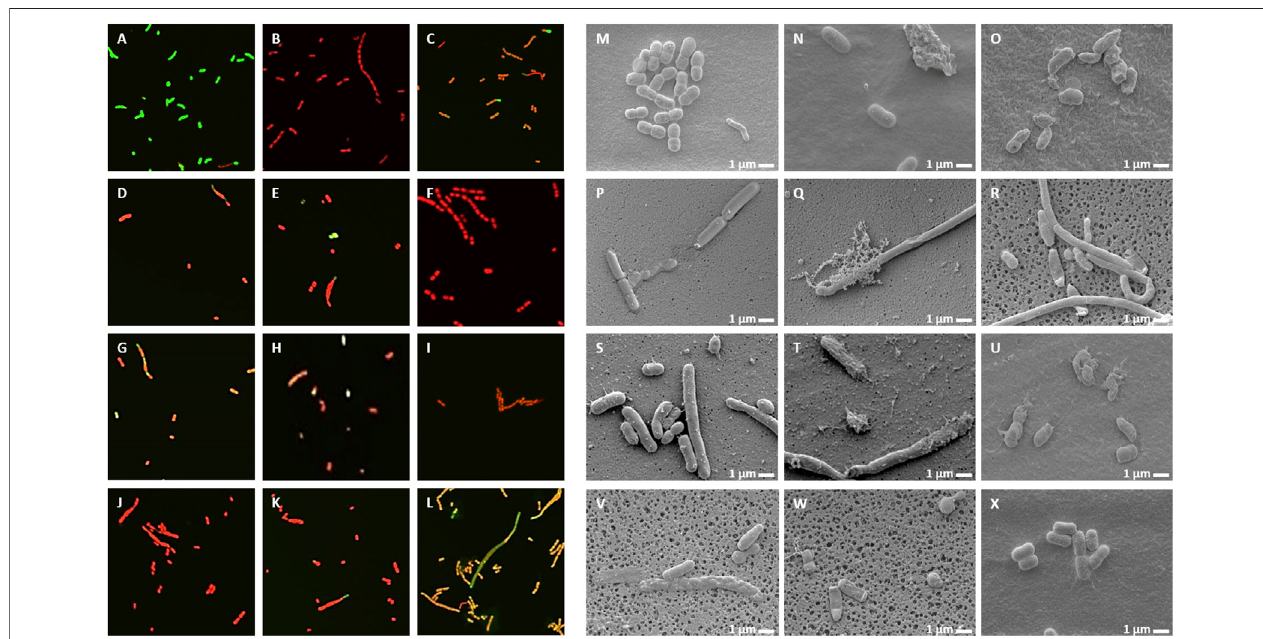
FIGURE 3 | Viability, membrane permeability and morphology of A. baumannii cells after NCR treatment (A – L) SYTO9/PI staining observed with confocal microscope, (M – X) Cell morphology observed with SEM. (A,M) untreated control, (B,N) CaNCR13, 3.125 µM, (C,O) CaNCR63, 3.125 µM, (D,P) CaNCR63 1-20 , 3.125 µM, (E,Q) CaNCR63 15-34 , 3.125 µM, (F,R) MsNCR443, 3.125 µM, (G,S) MsNCR463 16-35 , 1.6 µM, (H,T) MsNCR463 17-30 , 3.125 µM, (I,U) PsNCR349, 1.6 µM, (J,V)